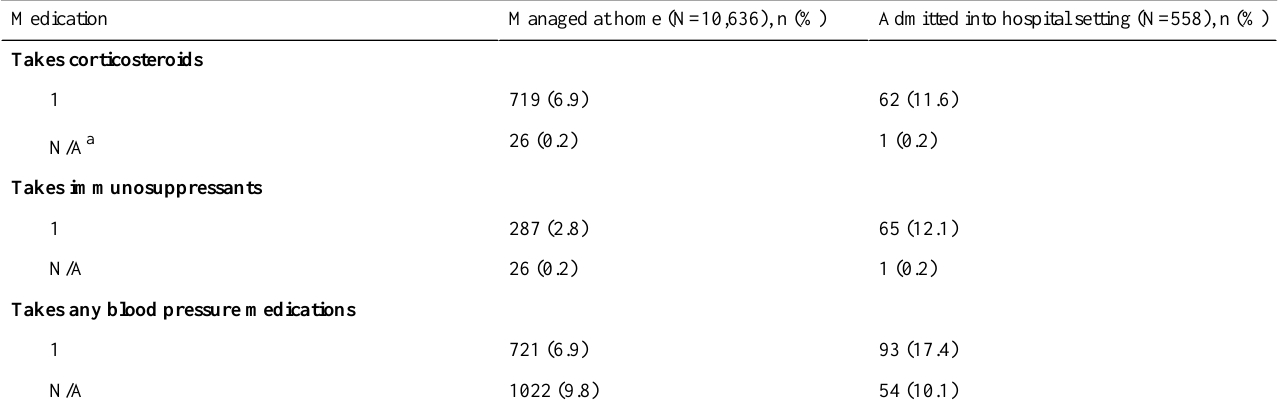
Table 4. Features of medication history investigated in relation to whether a user was seeking treatment. All features were binary.